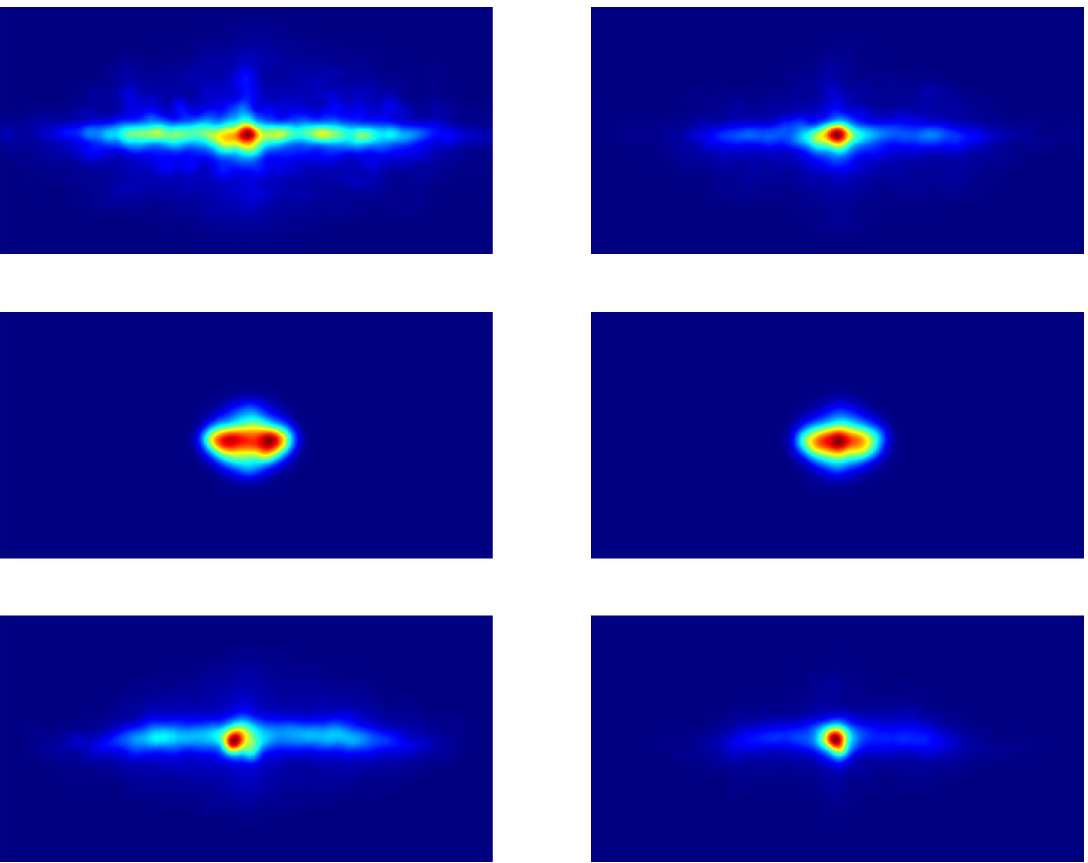
Fig 2. Encoding and recognition heatmaps. Encoding heatmaps are presented in the panels on the left side and recognition heatmaps in the panels on the right side. The top row shows the heatmaps of the eyes in world coordinates, the middle row the eyes in head-centered coordinates, and the bottom row the head positions in world coordinates. The coordinates of the heatmaps are all shown with longitudes in the range of − 180˚ to 180˚ (from west to east) and latitudes in the range of − 90˚ to 90˚ (from the south pole to the north pole). Note that for ease of comparison, the eyes in head-centered coordinates are shown with the same coordinates even though eyes in head coordinates are restricted to longitudes of about − 70˚ to 70˚ (from west to east) and latitudes of about − 60˚ to 60˚ (from south to north).